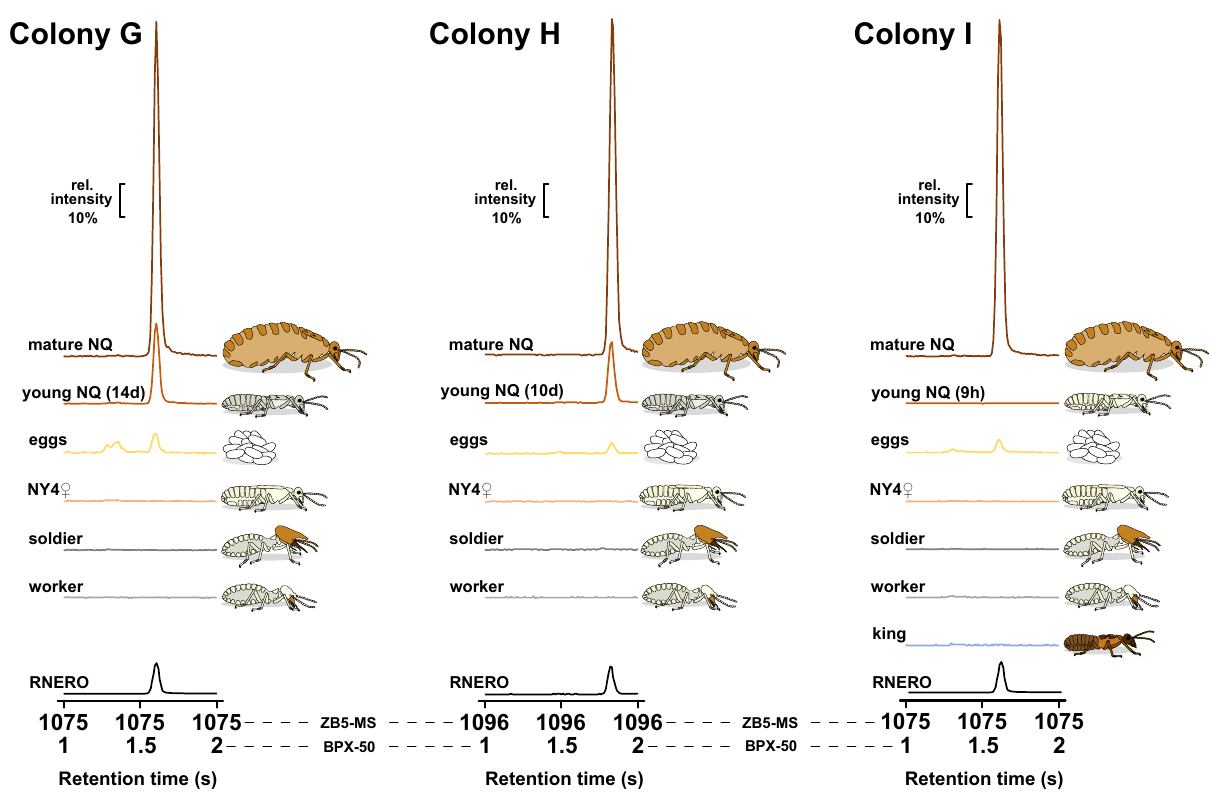
Fig. 3 Mature NQs and eggs from the three colonies used in queen inhibition bioassays produce RNERO. Figure shows portions of 2D gas chromatograms of hexane washes of various available castes and life stages from colonies G – I, and of synthetic RNERO standard. Termites were sampled into identical amounts of solvent (30 µ l/ind., 30 µ l/approx. 50 eggs) directly from the colonies, except for young NQs, which were obtained in the bioassays and held in colony fragments for 9 h, 10, or 14 days. Figure depicts a portion of one modulation period (1 – 2 s) of the secondary column (BPX- 50) at the elution time of RNERO from the primary column (ZB5-MS). The shift in retention times of RNERO is due to the exchange of columns between analyses performed in 2021 (G, I) and 2022 χ 2 = 13.16, df = 2, p = 1.4 × 10 − 3 , Fig. 5e) due to the signi fi cant (Fig. 4d). Likewise, all but one among 54 genotyped females (44 differences between the control and both treatments (colony H: NY4 ♀ + 10 NQs) were of parthenogenetic origin in colony H, p = 0.0142 for control vs. 10NQ and 0.0133 for control vs. having 249 NY4 and 1% of males (Fig. 5d). Out of the 10QE#; colony I: p = 7.1 × 10 − 3 for control vs. 10NQ and 72 successfully genotyped females (65 NY4 ♀ + 7 NQs) from 6.9 × 10 − 3 for control vs. 10QE#; corr. α = 0.0169). When the